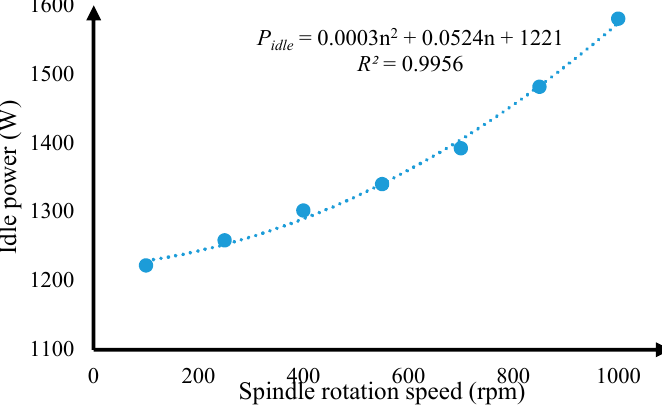
Figure 4. The idle power at different spindle speed.